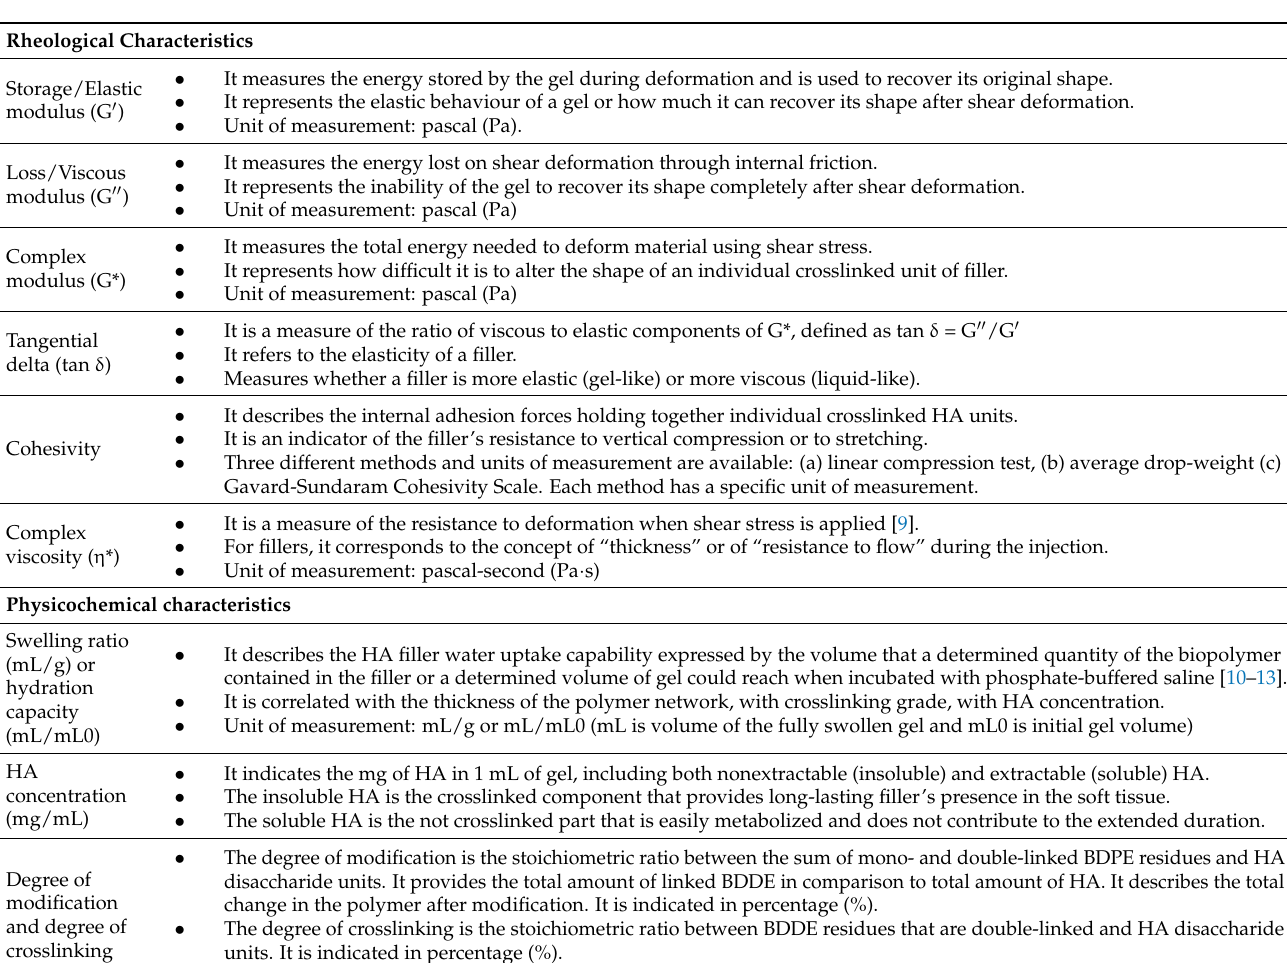
Table 1. A summary of filler rheological and physicochemical characteristics and their clinical